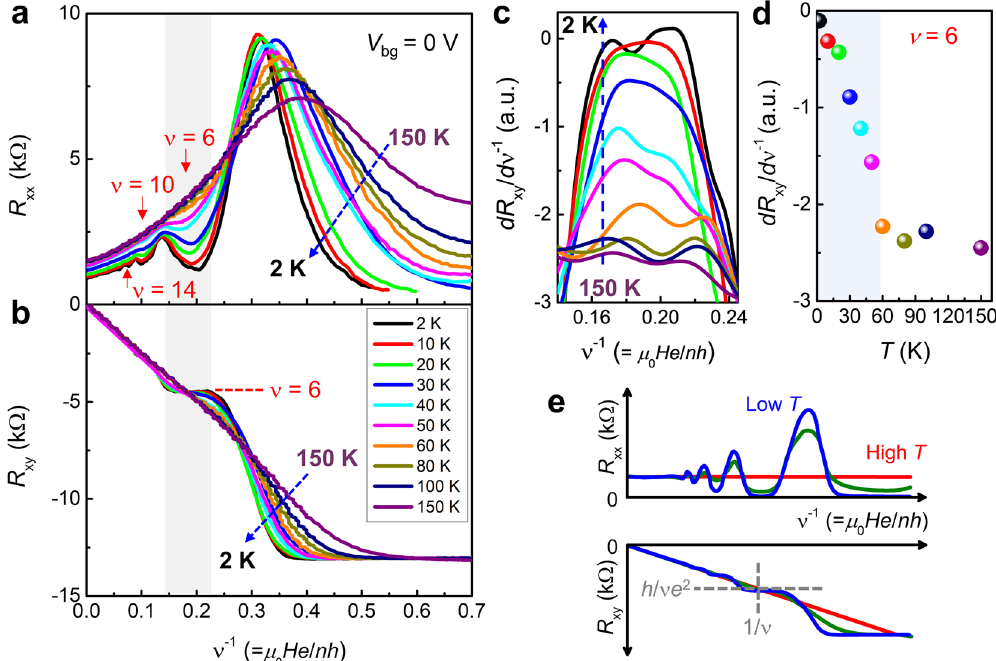
Fig. 4 Scaling of R xx and R xy in terms of ν -1 and magnetization-enhanced magnetic fl ux density (D1). a , b R xx and R xy vs. ν − 1 ( = μ 0 He / nh ) with respect to temperature. The gray shaded area indicates the region in which ν = 6, where the typical temperature-dependent QH effect is observed. R xx shows a fi xed dip and R xy crosses near ν = 6, at a different temperature, in the gray region. Higher fi lling factors of 10 and 14 are indicated by red arrows. c Slope of R xy vs. ν − 1 (i.e. dR xy / d ν − 1 ) near ν = 6 from 150 to 2 K. d Plot of temperature-dependent dR xy / d ν − 1 at ν = 6. e Schematic of R xx and R xy vs. ν − 1 for typical QHE of graphene with respect to temperature. At fi lling factor ν , R xy evolves from linear (red) to plateau (blue) with decreasing temperature. At intermediate temperatures, R xy deviates slightly from linearity near ν